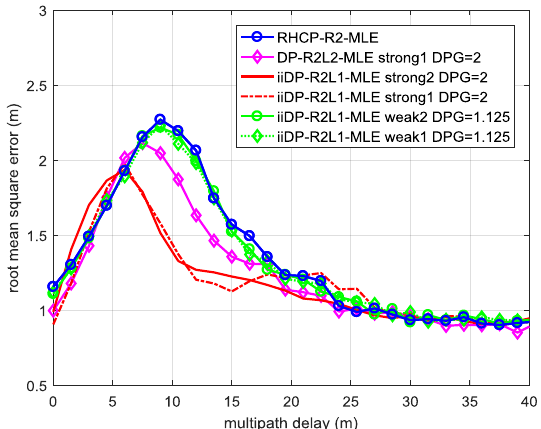
Figure 6. The RMSE of the TOA estimation of the LOS signals of the proposed iiDP-R2L1-MLE in different received signal cases defined in Table 2. different received signal cases defined in Table